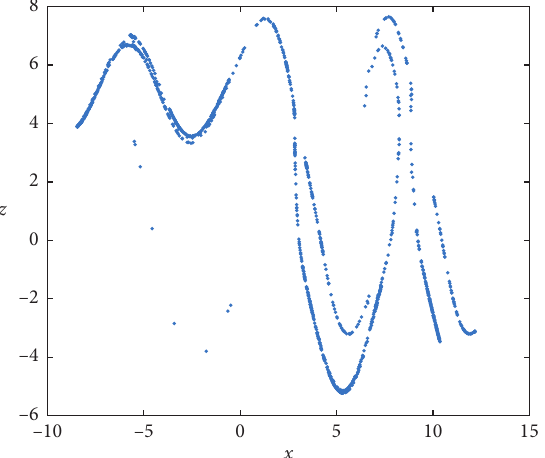
Figure 5: Poincar´e map in the x - z